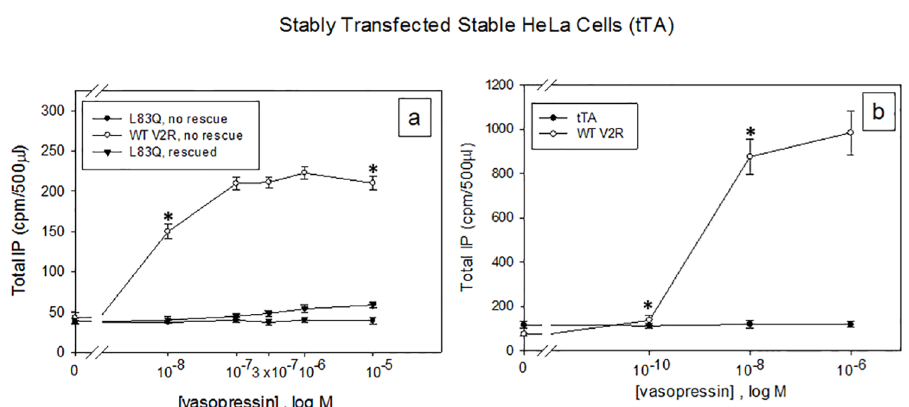
Fig 3. IP production from HeLa cells stably expressing WT V2R, mutant L83Q or tTA. Stably transfected HeLa cells containingtTA + hWTV2R or tTA + L83Q mutant were used to compareGq (IP) coupling(a) with the vasopressin receptor with or without 10 μ M SR121463B pharmacoperone(rescues the L83Q mutant), DMSO (vehicle) is a negative control. (b) Stably transfected HeLa cells with the WT V2R or tTA alone,were used to show if the oxytocin, V1a or V1b receptors are being stimulatedwith vasopressinto produceIP. Cells were stimulatedwith various doses of vasopressin for 2 h becausethe HeLa cells producelow amounts of total IP with the addition of 5 mM LiCl. The results shown in the figure are from at least 3 independent experiments performed in quadruplicate(n = 3 ± SEM), p value < 0.05 is considered significant. https://doi.org/10.1371/journal.pone.0181830.g003 Fig 4 shows transiently transfected HeLa cells expressing WT V2R alone, the mutant L83Q alone, or both together. When L83Q alone was present, cells were either treated with SR121463B (rescued) or not. The data show that the WT receptor, couples to both Gq (4a) and Gs (4b), but the mutant only couples to Gs (4a, b). When both are present in the absence of